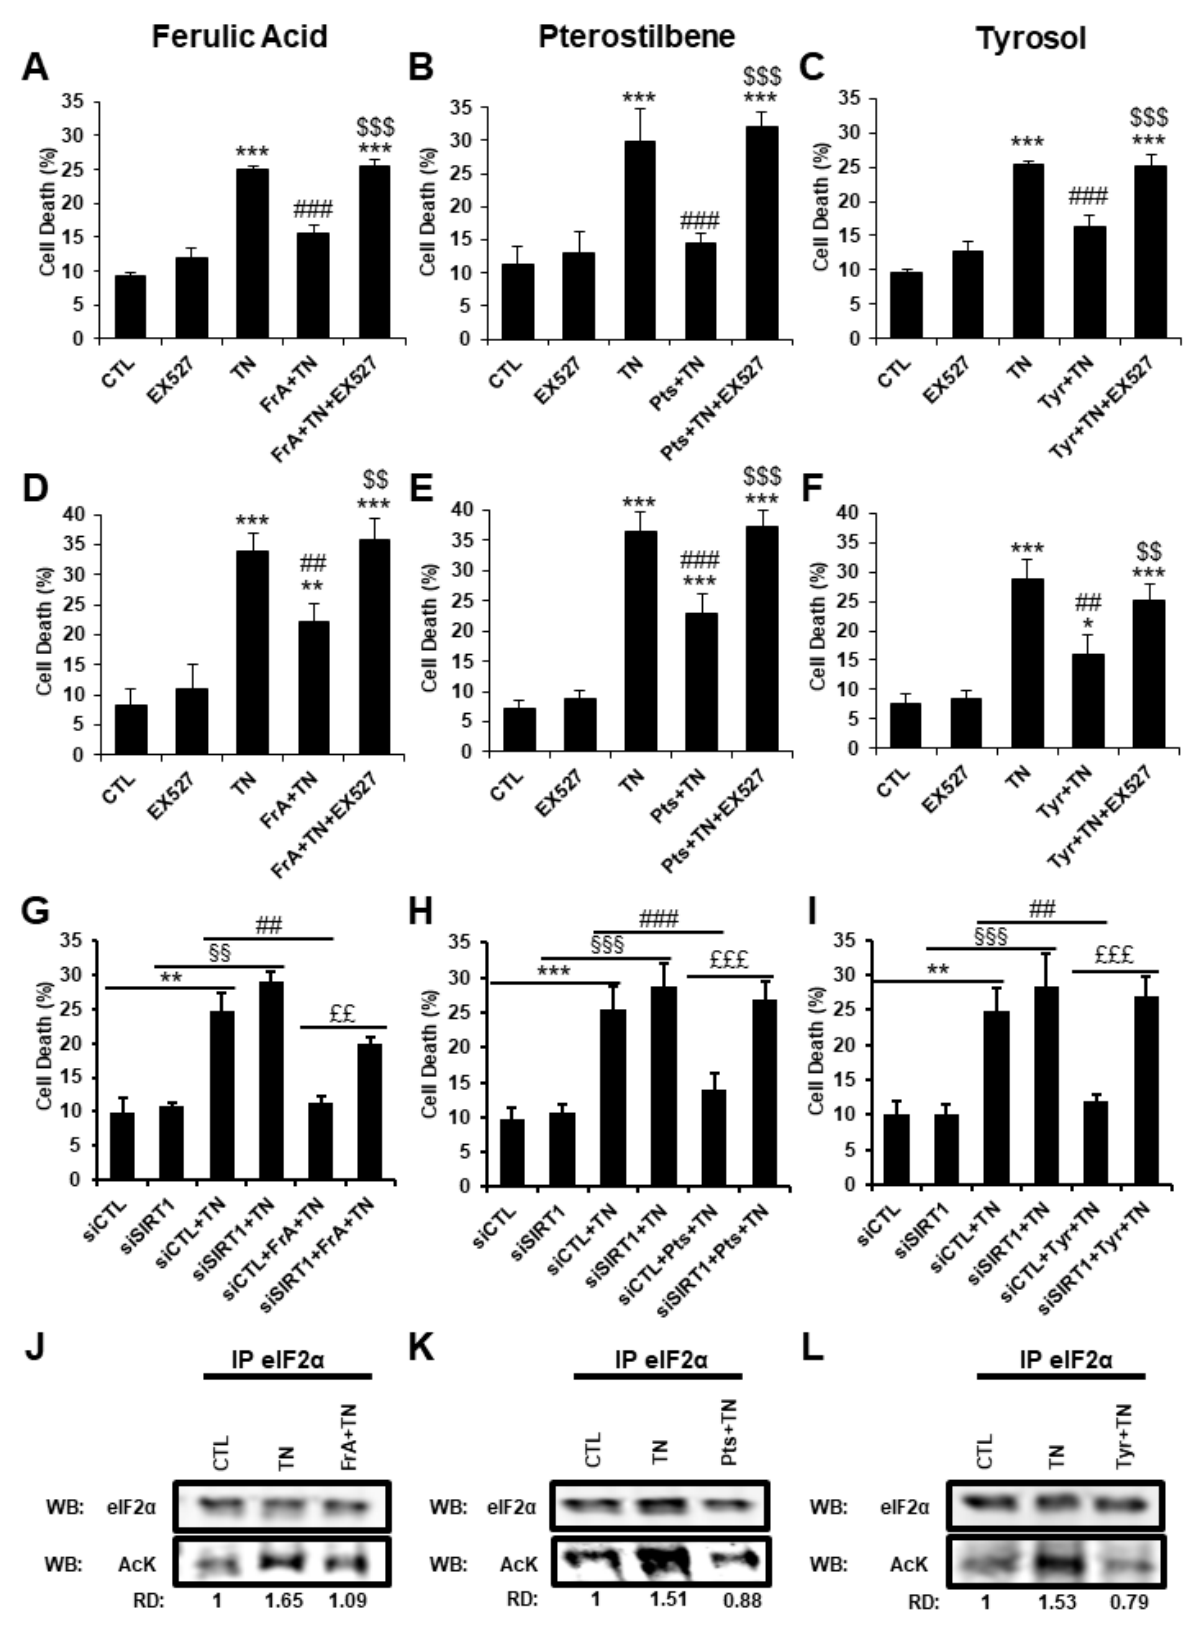
Figure 9. Ferulic acid, pterostilbene, and tyrosol protect cardiomyocytes from ER-stress-induced cell death through SIRT1-mediated deacetylation of eIF2 α . ARVM and H9c2 cells were pre-treated for 1 h with ferulic acid (FrA, 5 µ M), pterostilbene (Pts, 0.5 µ M), or tyrosol (Tyr, 1 µ M) with or without